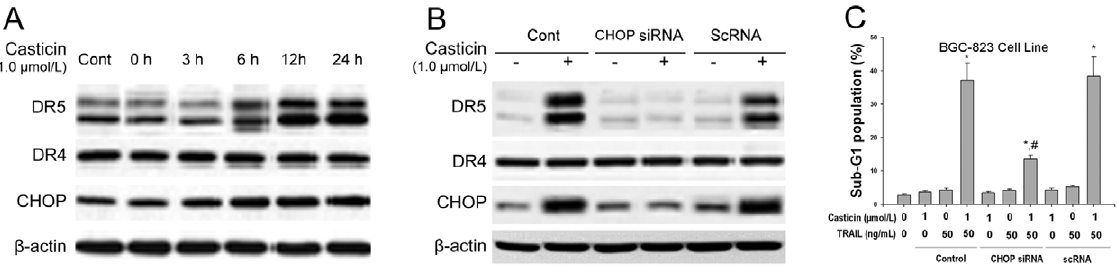
Figure 5. Silencing of CHOP by siRNA inhibited induction of DR5 upregulation by casticin and apoptosis by co-treatment with casticin and TRAIL in BGC-823 cells. Effects of siRNA for CHOP on the action of casticin-induced DR5 and CHOP expression (A and B) using western blot analysis and TRAIL-mediated apoptosis (C) in BGC-823 cells (mean 6 SD, n =3). * P , 0.05 vs. treatment with DMSO; # P , 0.05 vs. treatment with 1 m mol/l casticin plus 50 ng/ml TRAIL in control and scRNA transfected cells.